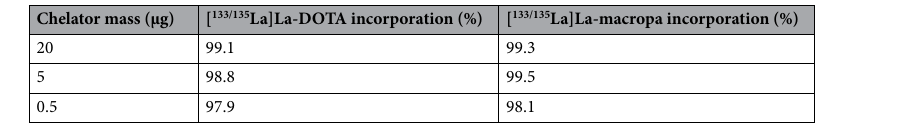
Table 4.. 133/135 La radiolabeling results with DOTA and macropa